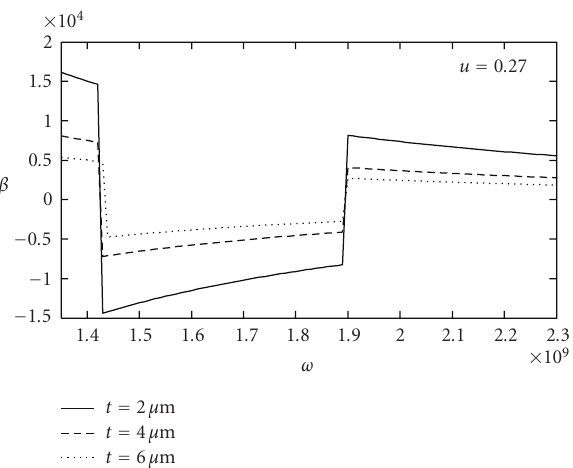
Figure 3: The e ff ective nonlinear refractive index versus the nonlinearity, at ω = 1 . 7GHz, ε 2 = 3, for di ff erent dielectric film thicknesses.